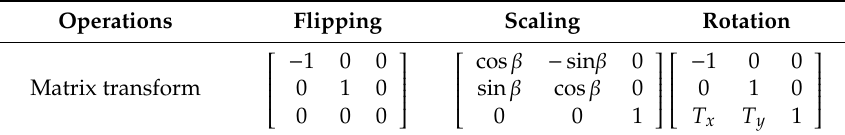
Table 2. A ffi ne transformation matrices for image augmentation.